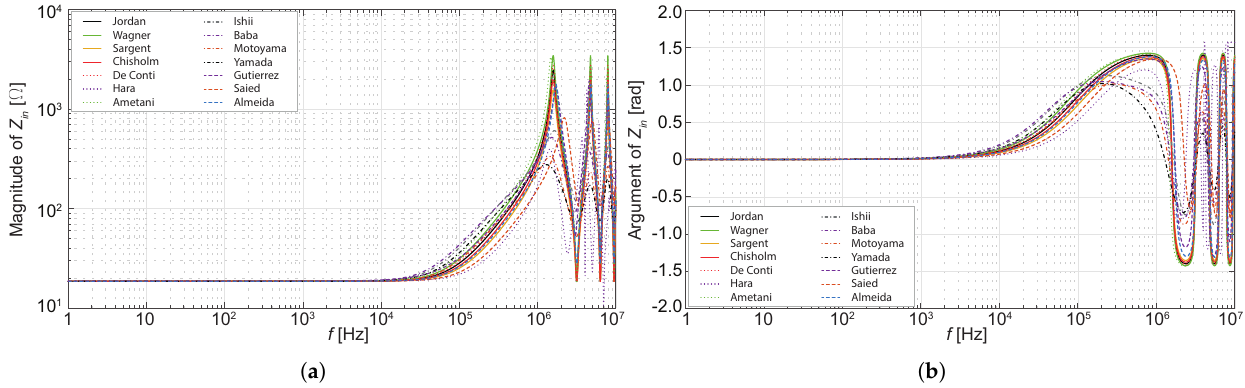
( f ) . ( f ) . ( b ) Argument of Z in in